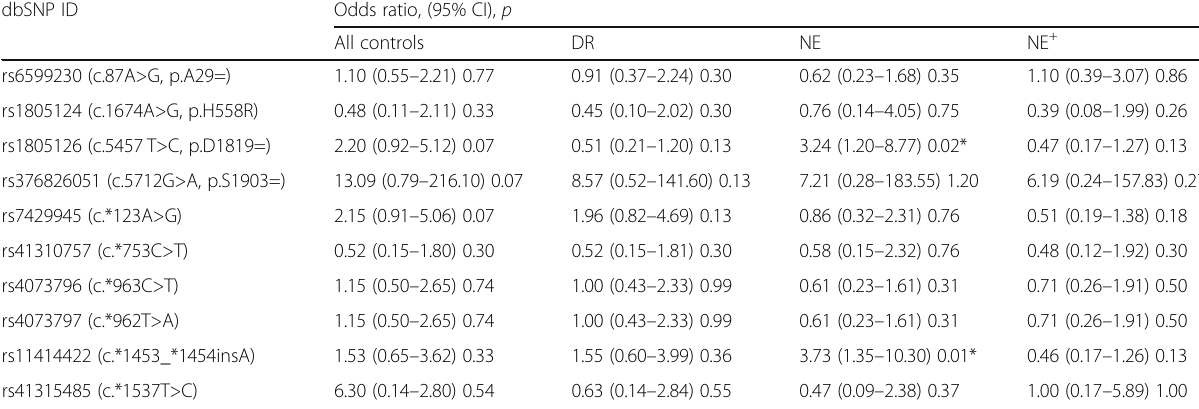
Table 4 Comparison between odds ratios of allele frequency from controls dbSNP ID Odds ratio, (95% CI), p All controls